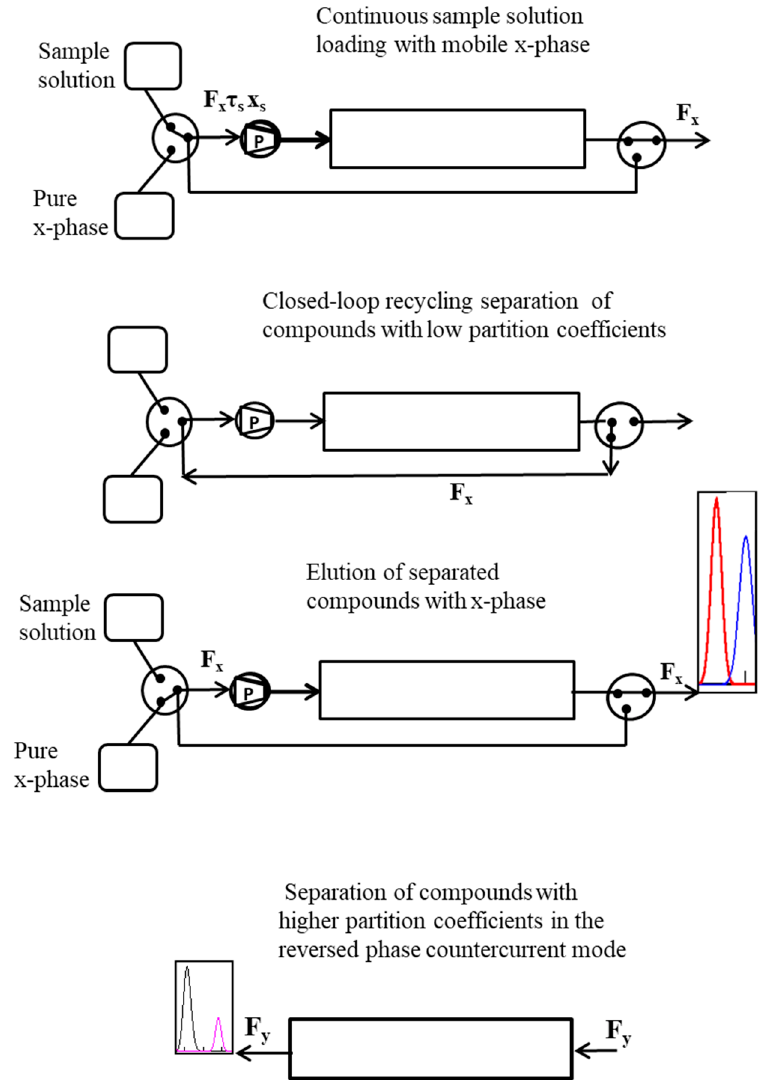
Figure 1. Schematic diagram of CLR DM CCC separations with specified sample loading durations: F x and F y are the volumetric flow rate of the x- and y-phase; x s is the sample concentration of the compound K D ; τ s is the sample solution loading time.